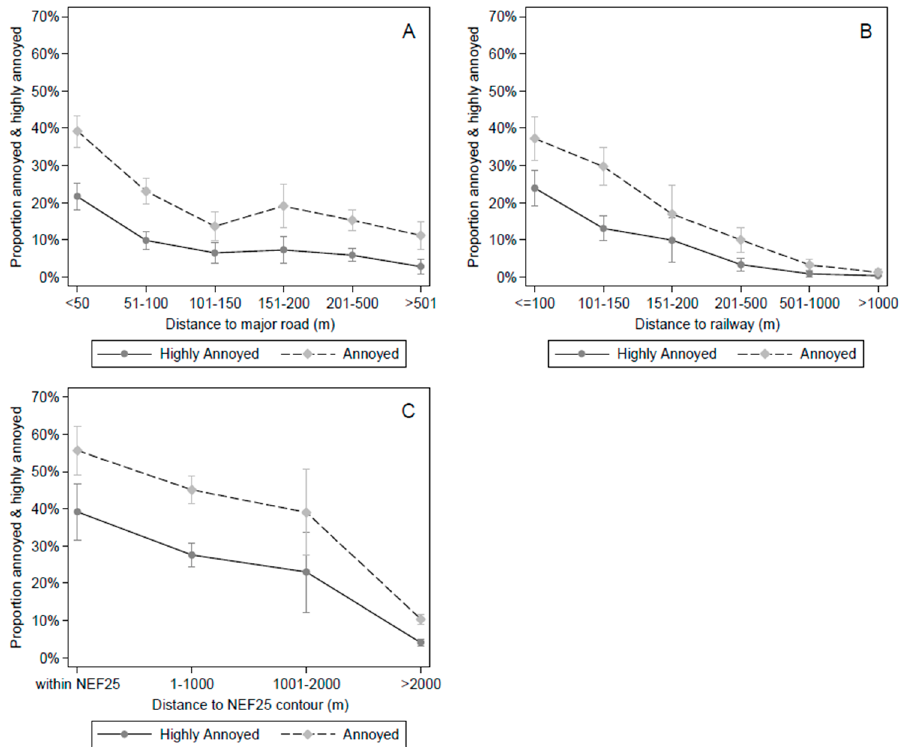
Figure 3. Estimated marginal proportions of annoyed and highly annoyed persons (with 95% CI) from road traffic ( A ); train ( B ) and airplane ( C ) noise by distance to the transportation sources (in categories), adjusted for age, education and sex.